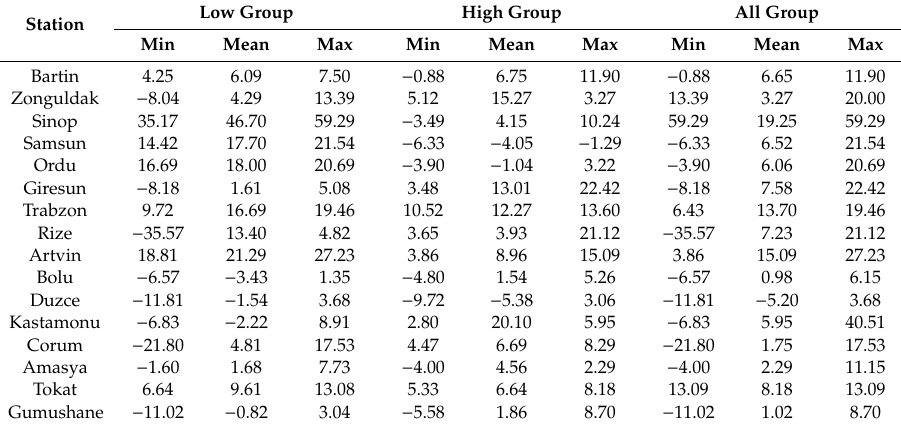
Table 5. Trends and change rates of annual rainfall at all stations using the ITA-CB (Minimum, mean and maximum percentage changes for each group are presented).